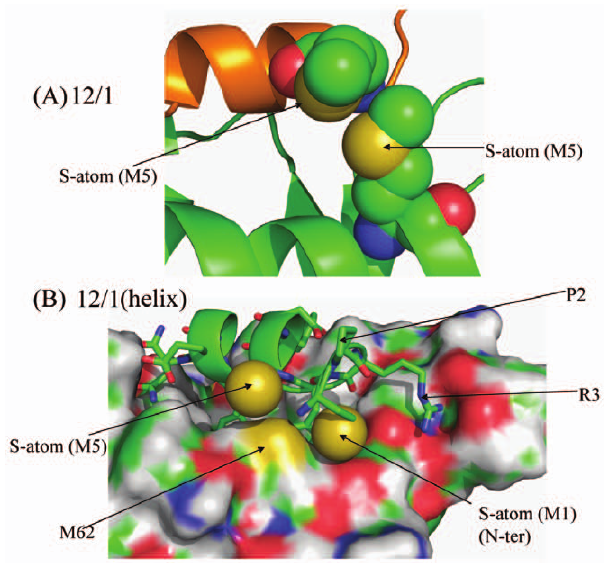
Figure 6. 12/1 peptide has the potential to form extra packing interactions with MDM2. (A) The equivalent position of S20 of the p53 family has been replaced by M5 in the 12/1 peptide family. Residue M5 packs much more favorably against M62 of MDM2 than the S20 residue in the p53 based peptides. (B) If the first three residues of the 12/1 family are modeled as a helix, even though this was not observed in the simulation, the M1 residues would also pack favorably against the M5 12/1 residue of 12/1 and the M62 residue of